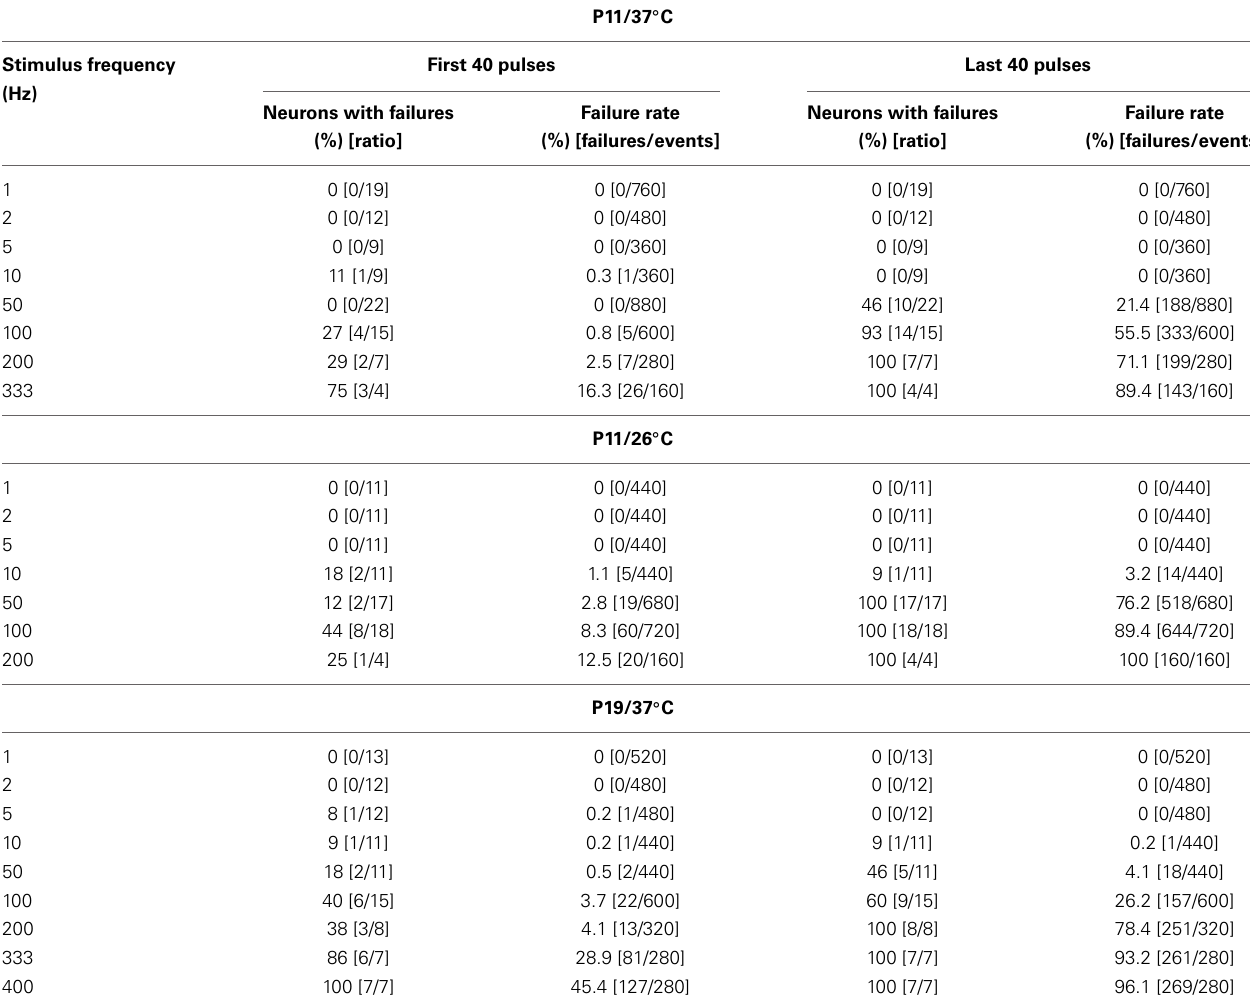
Table 2 | Failure analysis of glycinergic IPSCs evoked in the MNTB-LSO